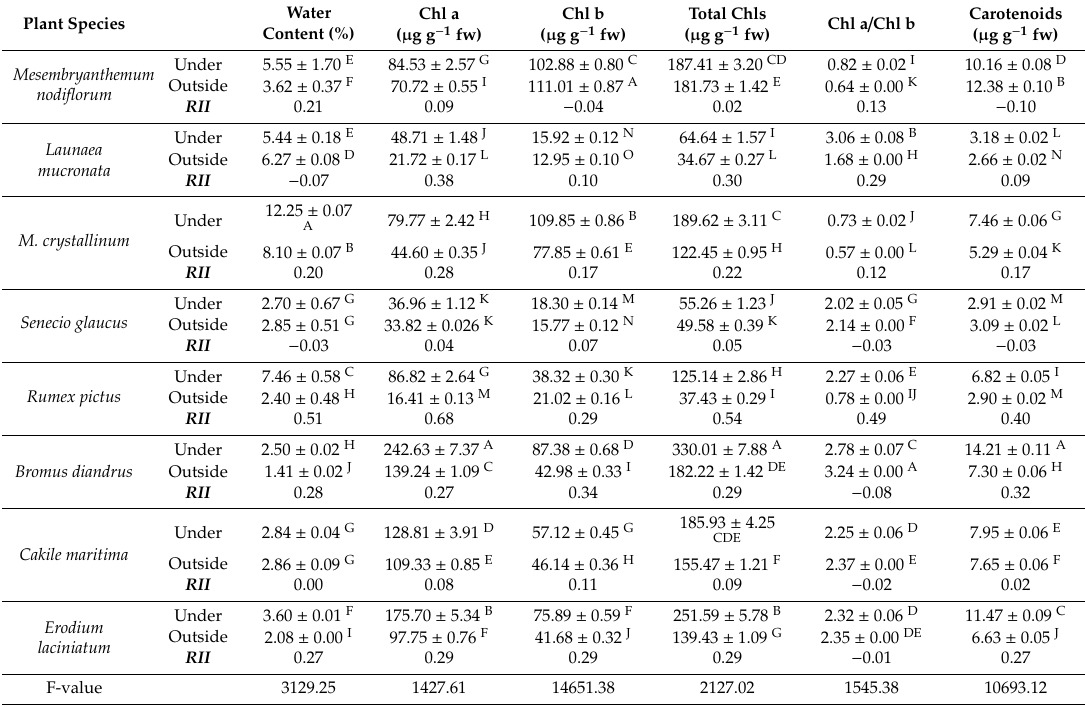
Table 2. Water content and photosynthetic pigments of the eight selected associated under canopy and outside canopy of C. polygonoides as well as the relative interaction index